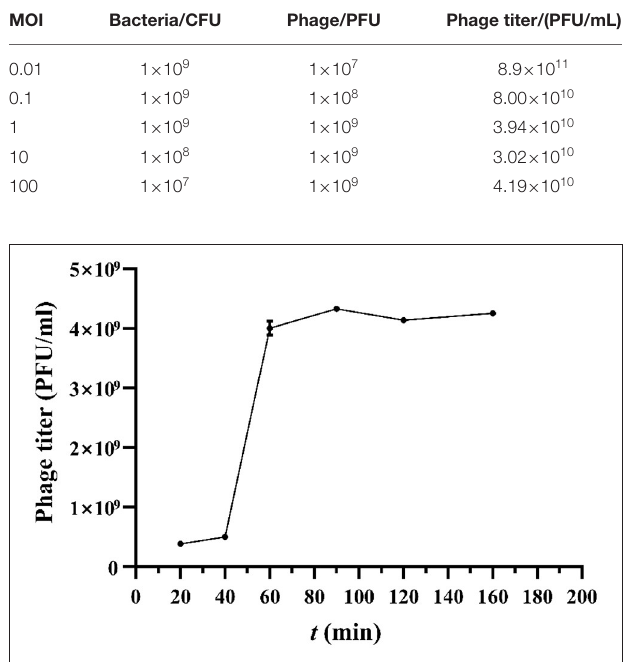
FIGURE 3 | One-step growth curve of vB_Kpn_B01.